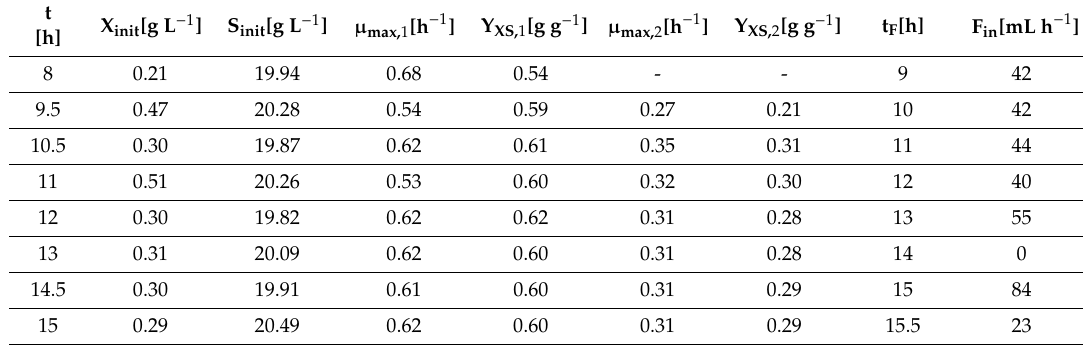
Table A10. Estimated initial concentrations for biomass X init and glucose S init and the estimated model parameters for the maximum specific growth rate biomass µ max and yield coe ffi cient biomass / substrate Y XS (for batch phase index 1 and for fed-batch phase index 2) at process timepoint t. Calculated optimized feed rate F in for timepoint t F .